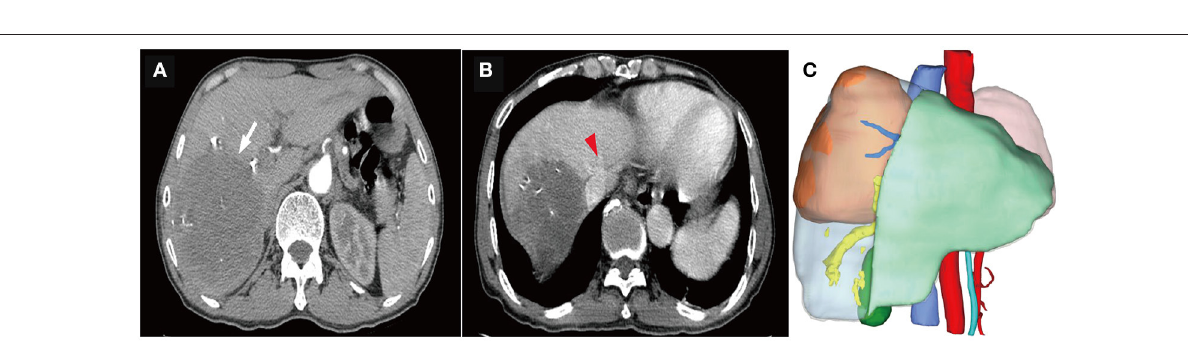
should take into account both the increase in functional FLR and local control of the